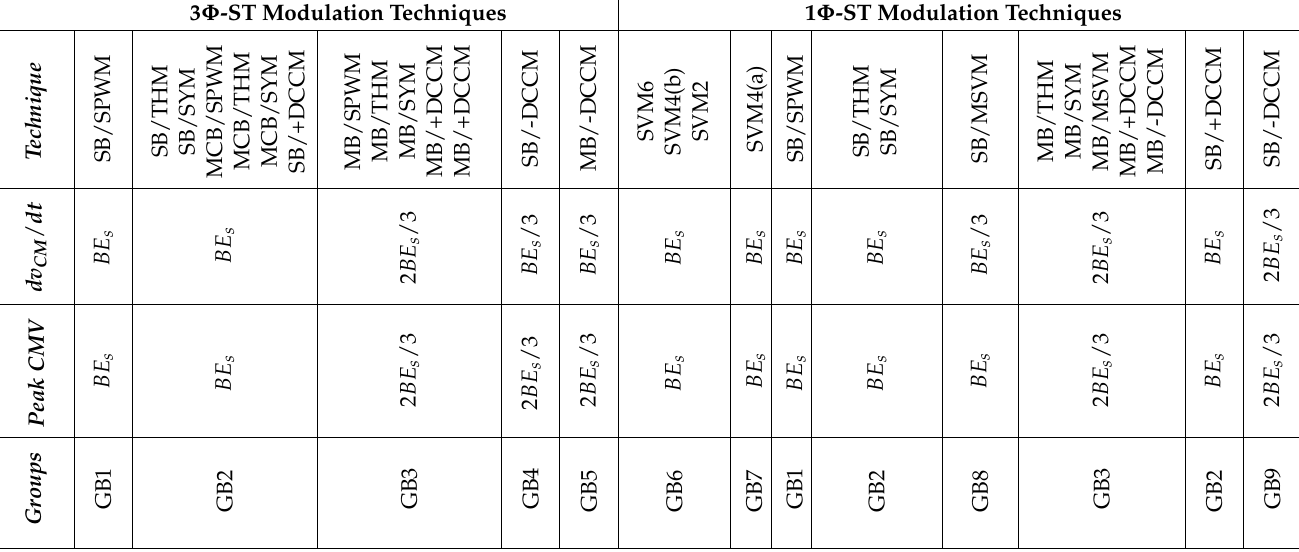
Table 4. The peak CMV and dv / dt for all presented modulation schemes. 3 Φ -ST Modulation Techniques 1 Φ -ST Modulation